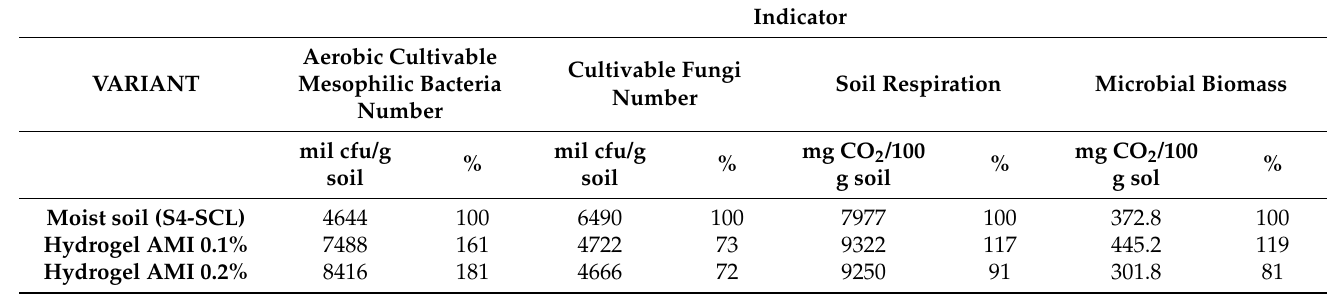
Table 4. Biologic indicators of sandy clay loam soil (S4-SCL) treated with AMI fertilizer.